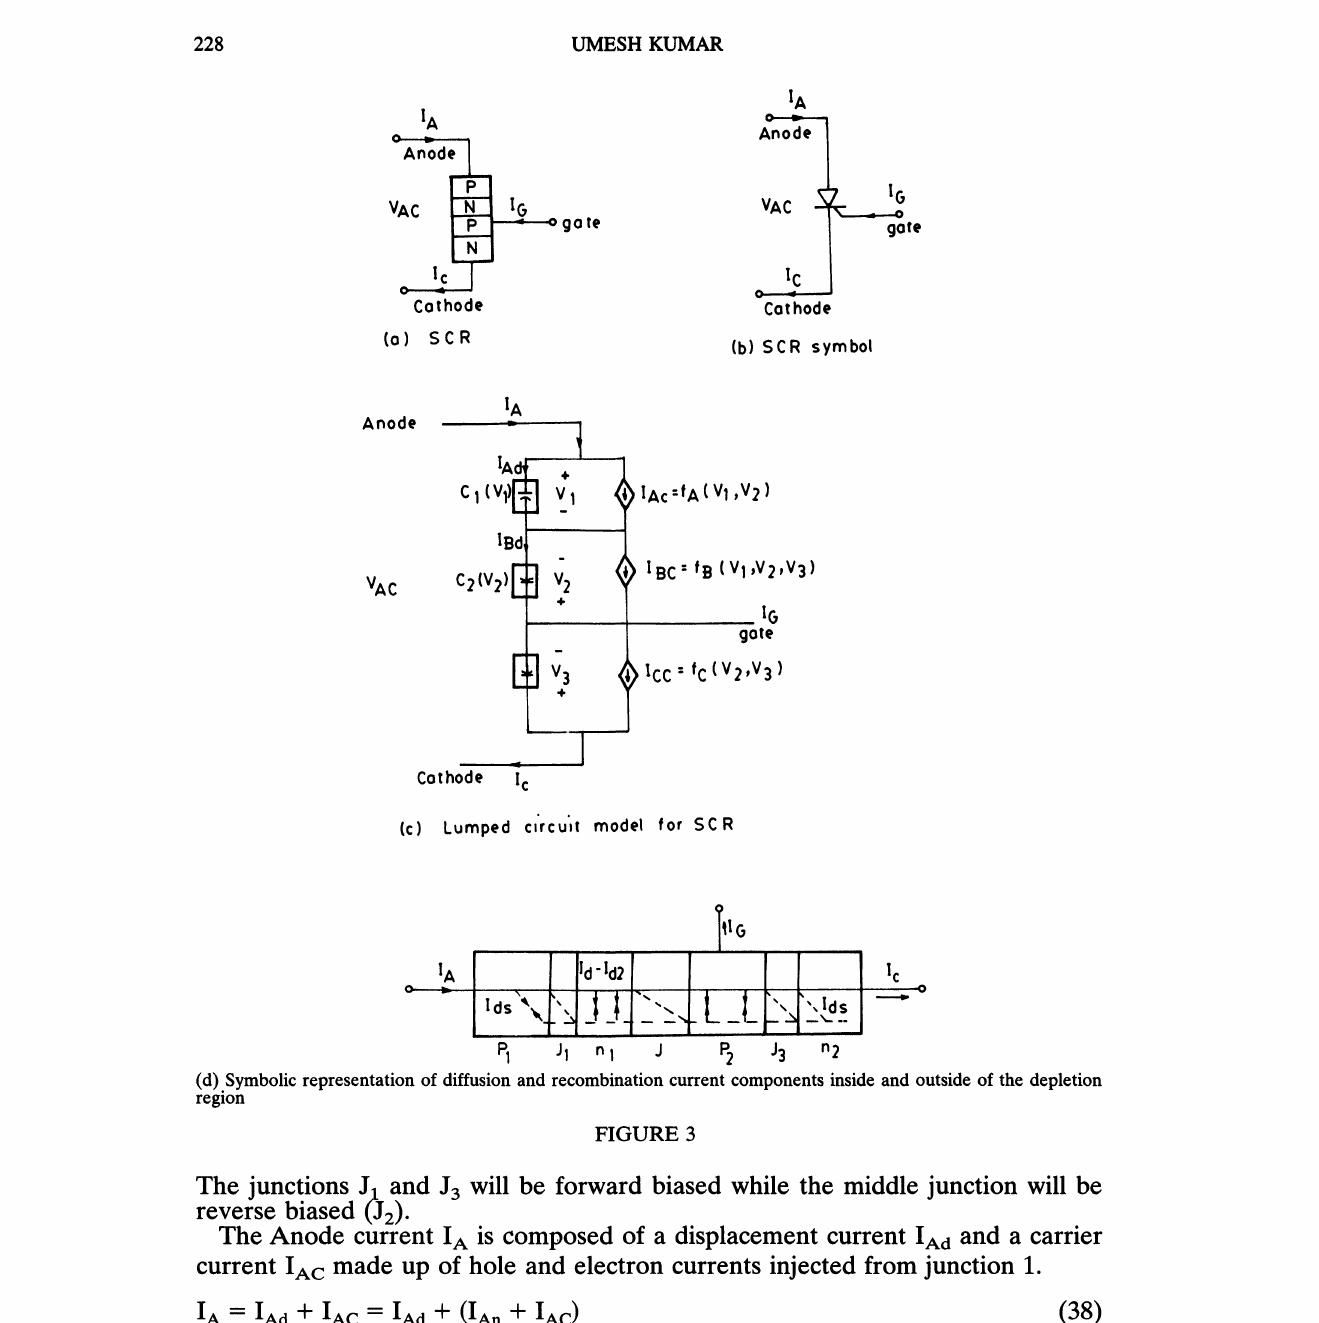
(d) Symbolic representation of diffusion and recombination current components inside and outside of the depletion